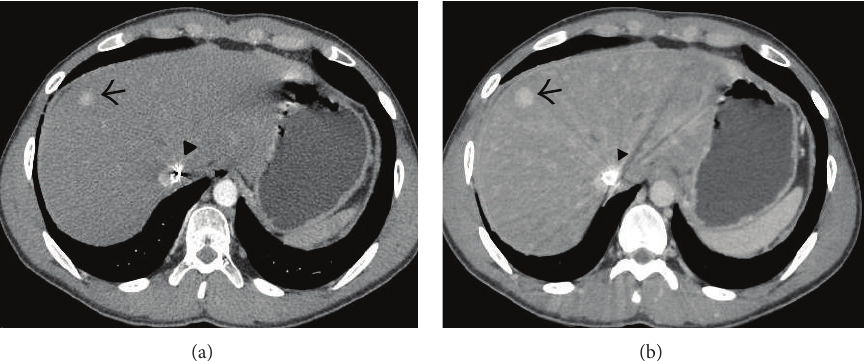
Figure 9: Axial CECT images acquired in the arterial (a) and venous (b) phase showing an arterial phase enhancing nodule (arrow in (a)) in liver which retains the contrast in the venous phase (arrow in (b)) consistent with regenerative nodule in this patient who had undergone direct intrahepatic portocaval shunt (DIPS) for BCS.